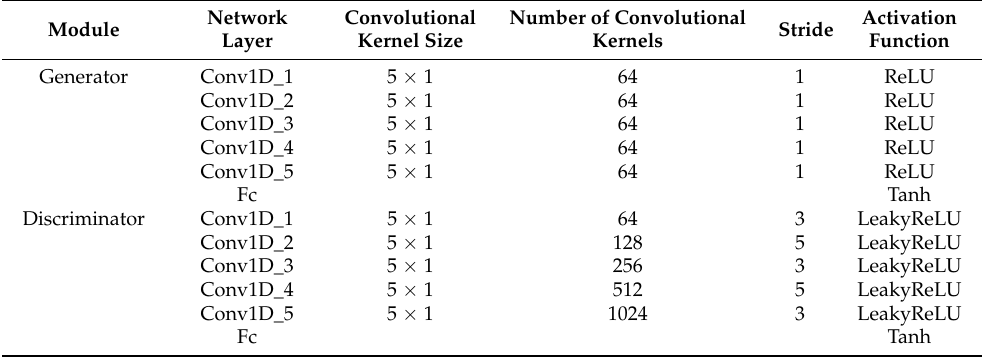
Table 7. The 1D-DCGAN parameter selection.